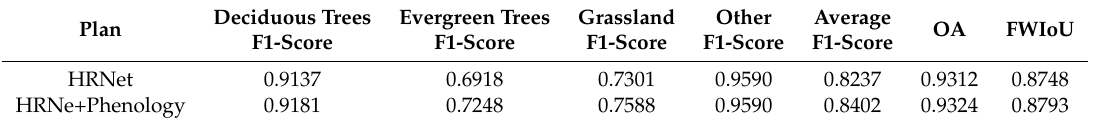
Table 4. Comparison of the accuracy of the methods with and without the phenology feature. Deciduous Trees Evergreen Trees Grassland Plan